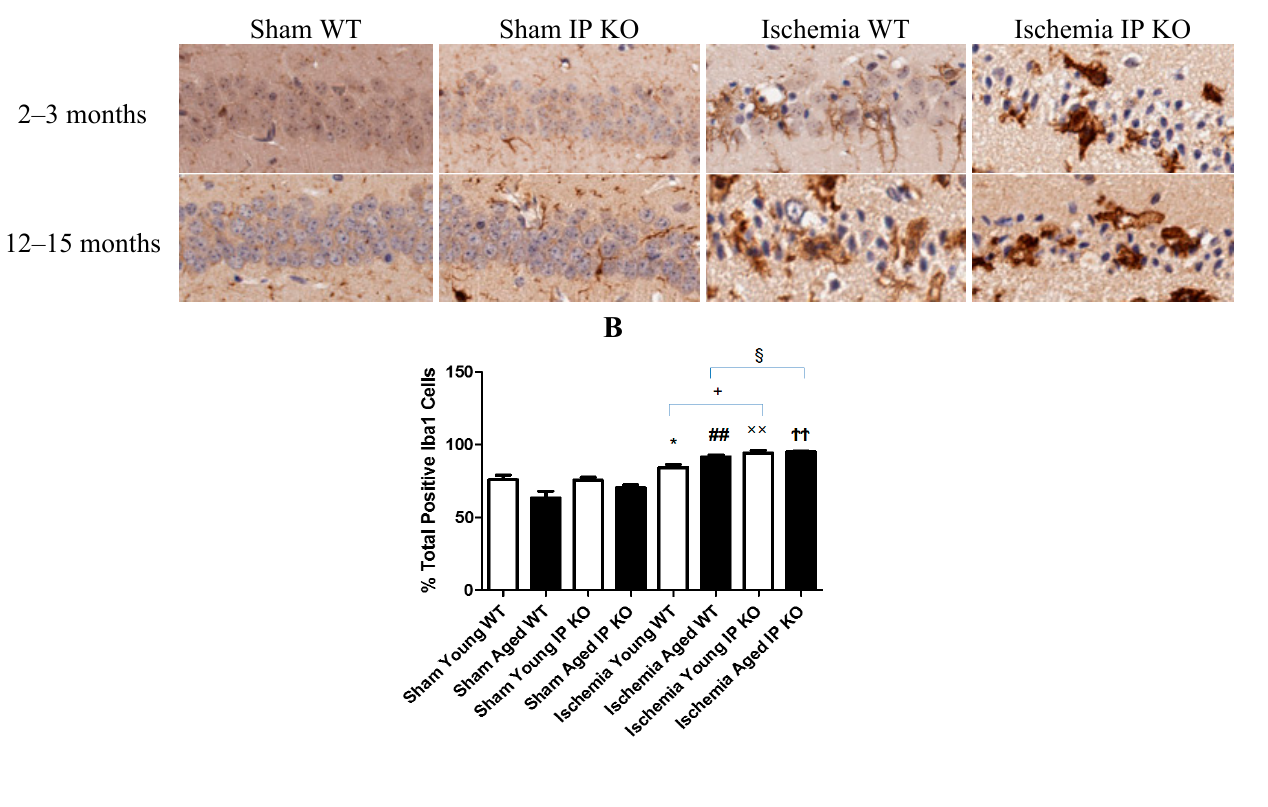
Figure 5. Microglia reactivity in young and aged WT and IP KO sham and ischemic mice after 12 min global cerebral ischemic insult. ( A ) Representative images of brain sections show microglia immunostaining. ( B ) Quantification of Iba-1-positive cells in the hippocampal CA1 subfield on day 7 after ischemia. ( n = 3 per group). * p < 0.05, ## p < 0.01, ×× p < 0.01, ϮϮ p < 0.01 for Ischemia vs. Sham; + p < 0.05, § p < 0.05 for Ischemia IP KO vs. Ischemia WT. A Sham WT Sham IP KO Ischemia WT Ischemia IP